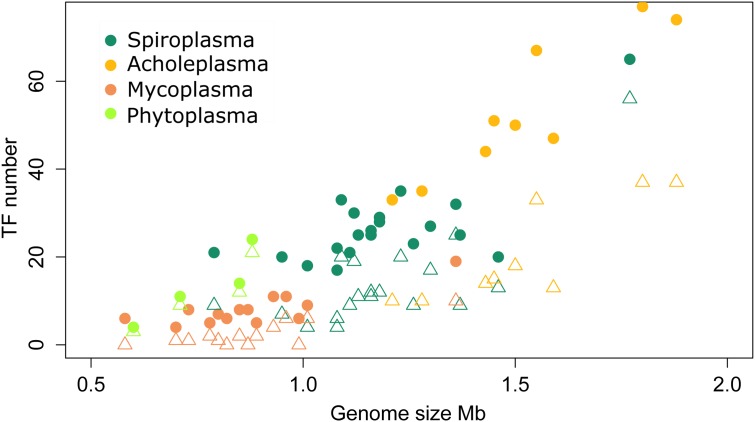
Transcription factors number variation across the Mollicutes. Circles represent the total number of TFs; triangles show the number of non-conserved TFs only present in one of the analyzed genomes.